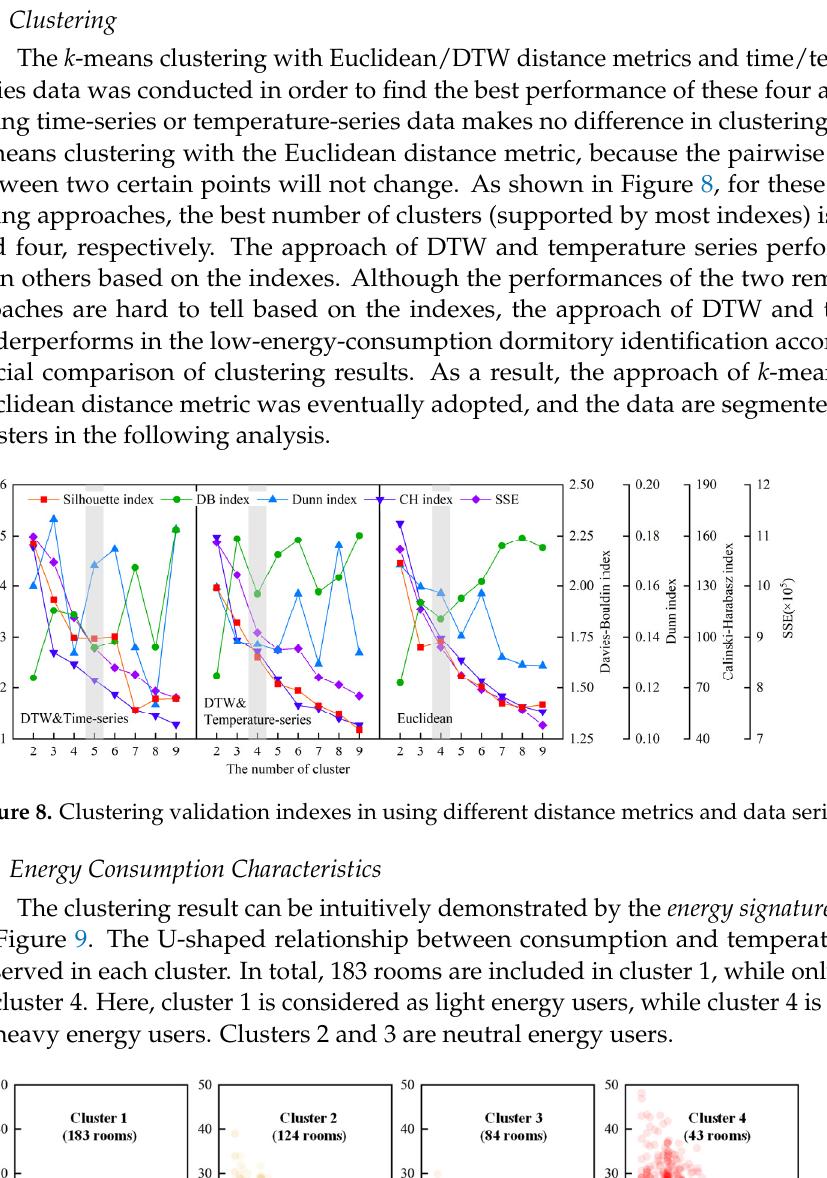
Figure 7. Raw energy consumption data of a typical dormitory and outdoor air temperature.